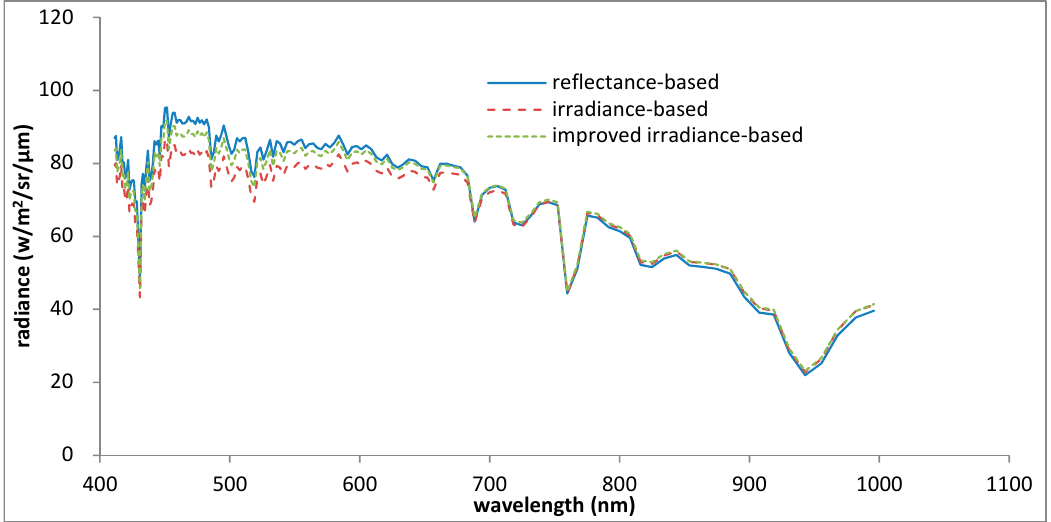
Figure 22. MODTRAN-simulated radiance for the SPARK-02 satellite calculated using reflectance-, irradiance-, and improved irradiance-based methods.